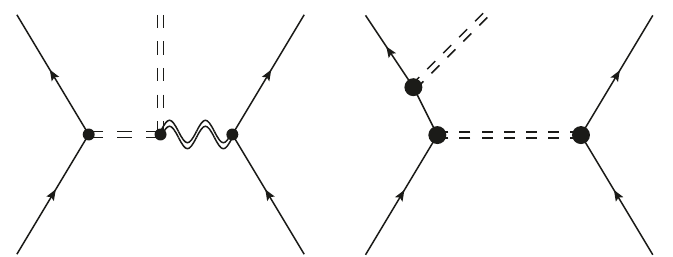
Figure 4. Diagrams with dilatons radiated into the (cid:12)nal state. The dilaton is represented by the double dashed line, while the graviton is the double wavy line.